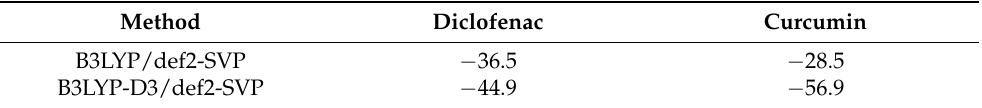
Table 4. Binding energies (BEs in kcal/mol) for diclofenac and curcumin in the respective complexes calculated the B3LYP/def2-SVP and B3LYP-D3/def2-SVP levels of theory.